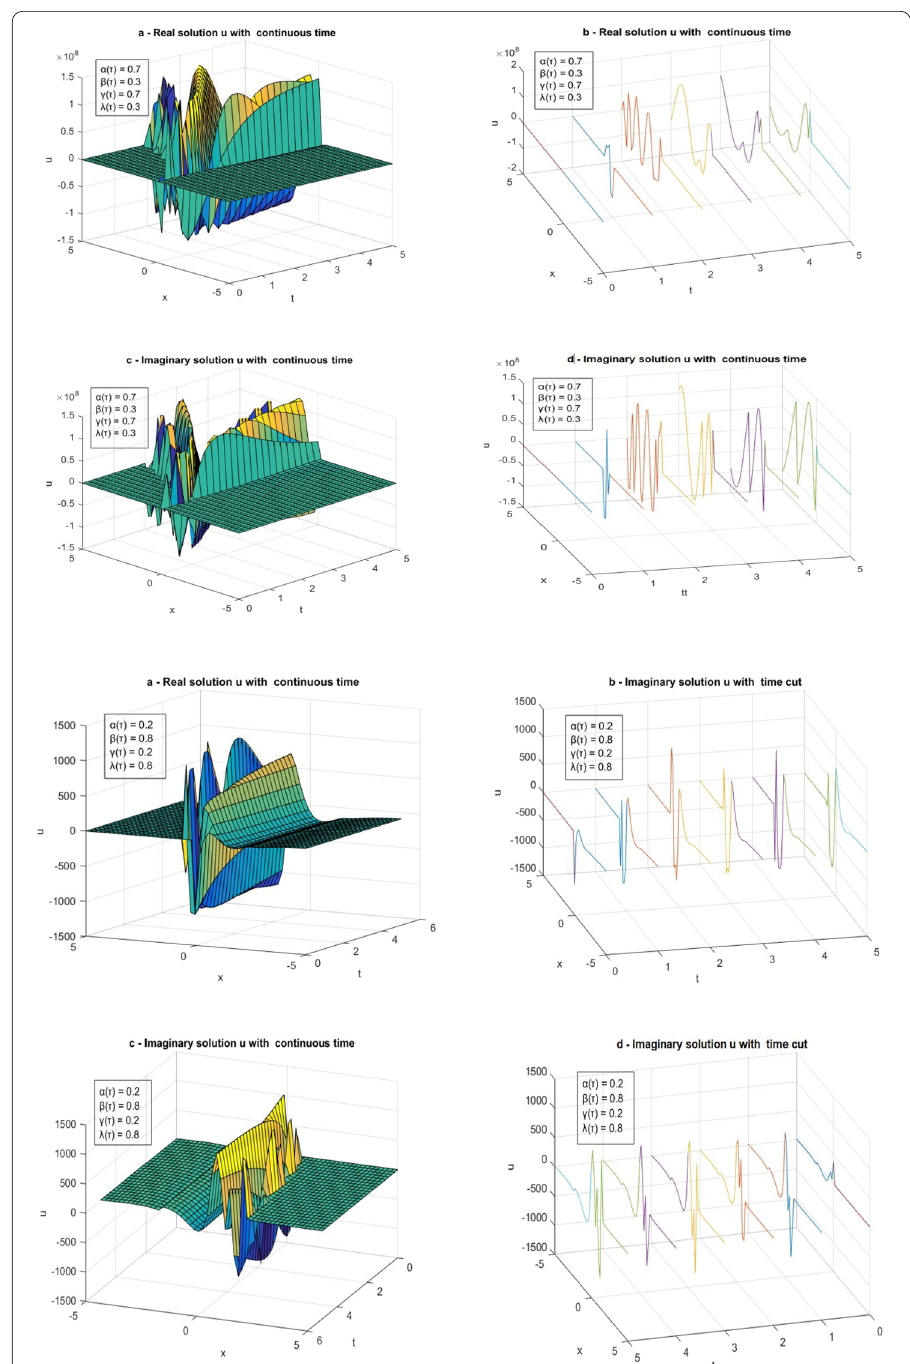
Figure 5 The graphs of the solution u in Example 2 with different values for α ( τ ), β ( τ ), γ ( τ ), and λ ( τ )